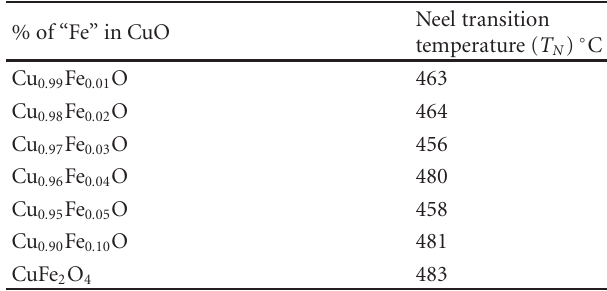
Table 5: Neel transition temperature of bulk CuO with “Fe” doped to various extent and pure CuFe 2 O 4 .